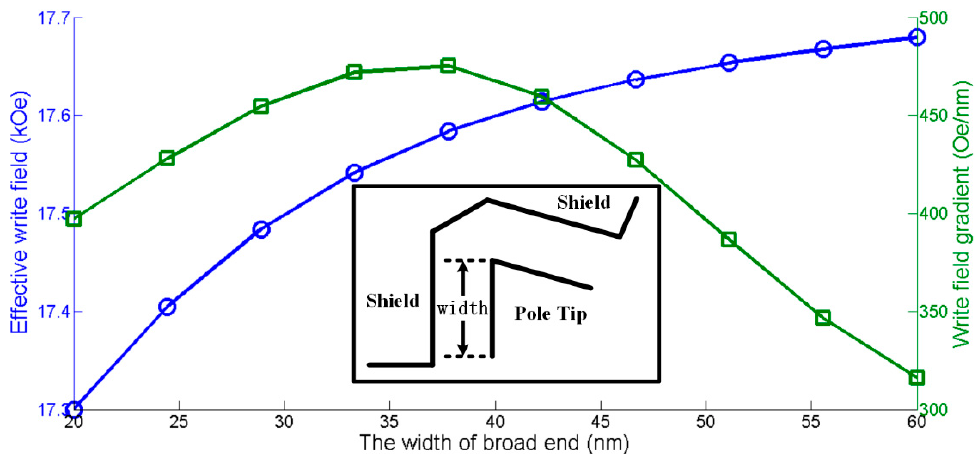
Figure 2. Effective write field and cross-track field gradient of shingled writer depends on the width of broad end (without rounded corner).